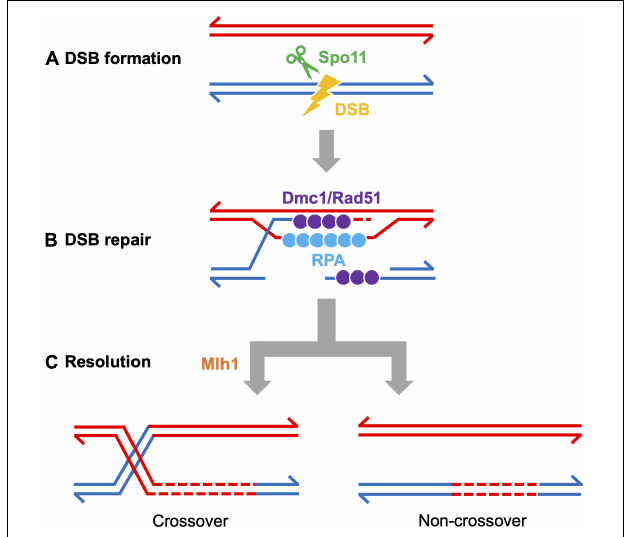
FIGURE 4 | Meiotic recombination pathway showing steps mediated by proteins described in the text. Adapted from Baudat et al., 2013. Red and blue lines represent double strand DNAs of maternal and paternal origins. Broken lines indicate newly synthesized DNA strands during DSB repair. (A) DSB formation requires the topoisomerase-like protein Spo11. (B) The repair of meiotic DSBs involves strand exchange mediated by the ssDNA binding complex RPA, the recombinases Dmc1 and Rad51, and Brca2. (C) Recombination intermediates are resolved to form either crossover or non-crossover products. Crossover resolution involves Mlh1. Other proteins have also been shown to act in meiotic recombination in mammals (reviewed in Baudat et al., 2013) and in budding yeast (reviewed in Yadav and Claeys Bouuaert, 2021). Presented proteins have been studied in zebrafish by mutation and/or cytological analyses. It has not been definitively shown that FANCL/Fancl acts at these stages in both mouse and